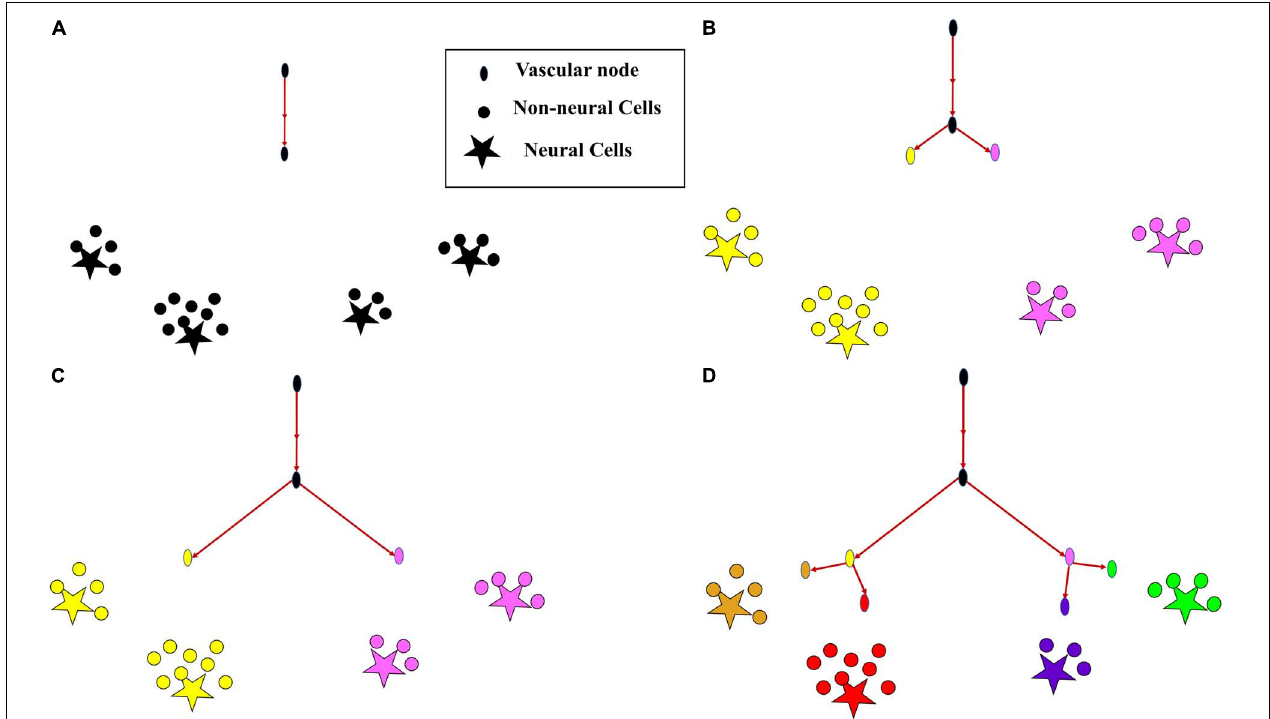
FIGURE 2 | The growth of vascular tree from a root node. (A) All cortical cells (neurons and non-neural cells) fed by a single vascular leaf node (black); (B) the earlier leaf node (black) splits into two leaf nodes (yellow and violet), splitting its perfusion domain also into two regions of cortical cells assigned to the yellow and violet vascular leaf nodes; (C) the yellow and violet vascular leaf nodes move towards the centroids of their respective perfusion domains; (D) once the equilibrium point is reached, the yellow node splits again into two leaf nodes (gold and red) and the violet node splits into two leaf nodes (blue and green), splitting their perfusion domains also into four regions corresponding to the four terminal leaf nodes (gold, red, blue, and